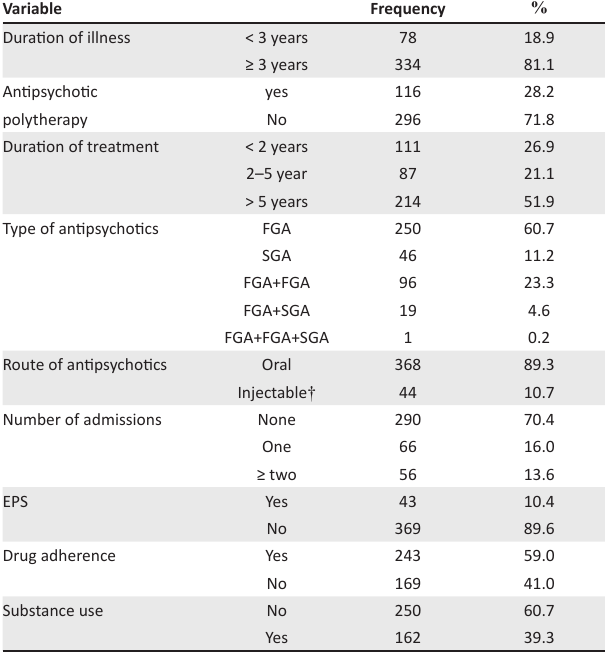
TABLE 1: Distribution of socio-demographic characteristics of schizophrenia patients attending at Amanuel Mental Specialized Hospital, Addis Ababa, Ethiopia, June 2014 ( n = 412).